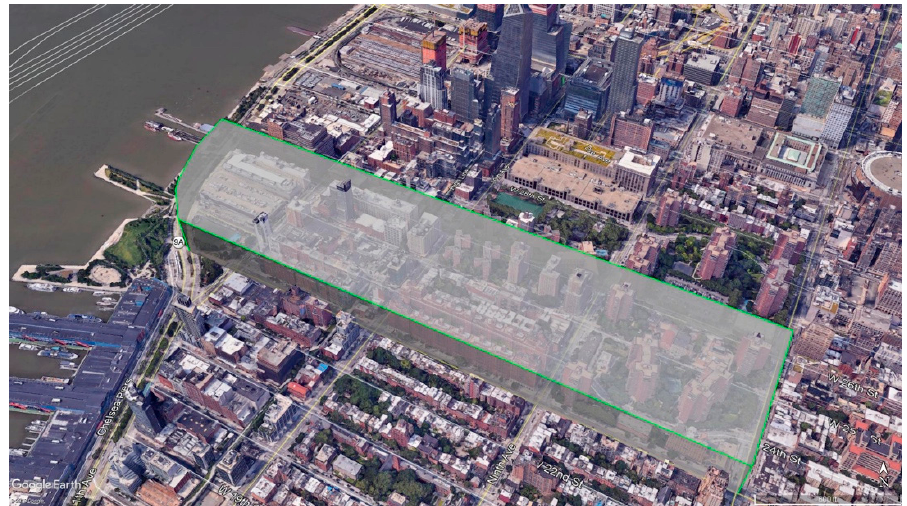
Figure 7. Case study area – NYEPA Basin 96 – 12th Avenue in the West, 8th Avenue in the East, 23st in the South and 26st in the North.